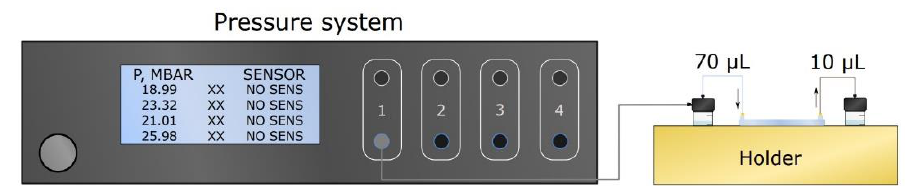
Figure 3. Pressure system setup used to provide fluid flow for single channel PDMS and OSTE-COC devices.